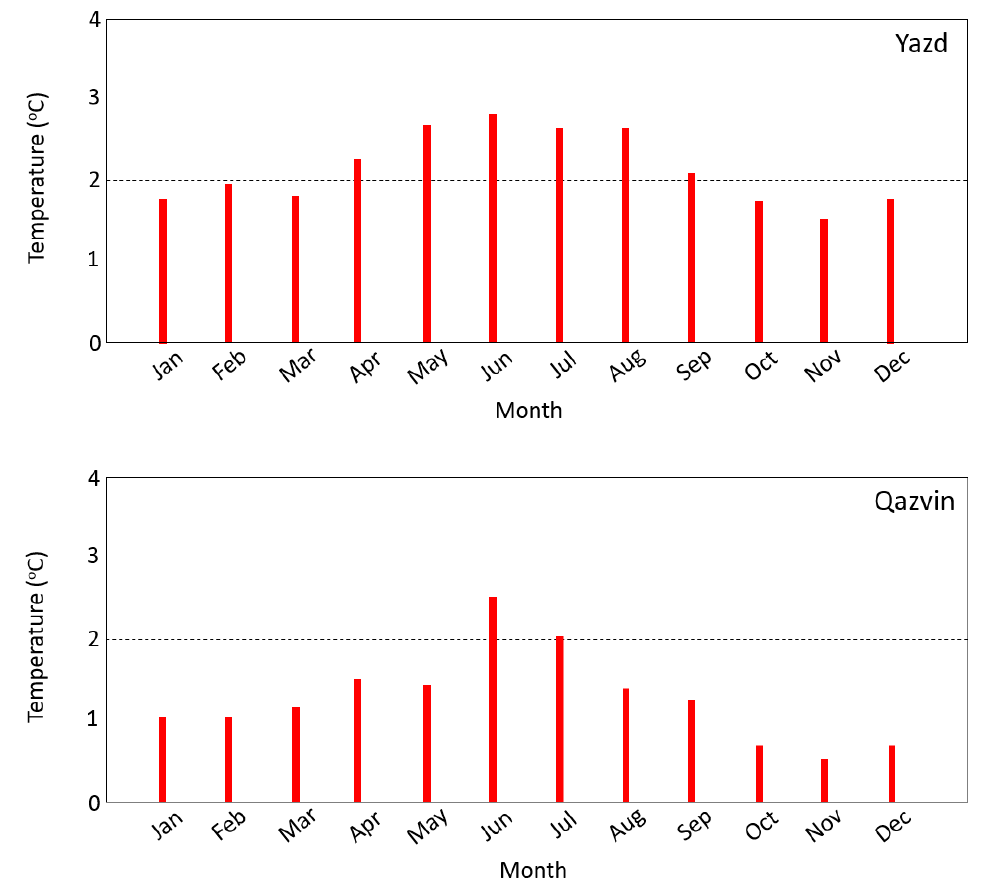
Figure 10. Difference between monthly average of predicted temperature from 2013 to 2020 and base period .